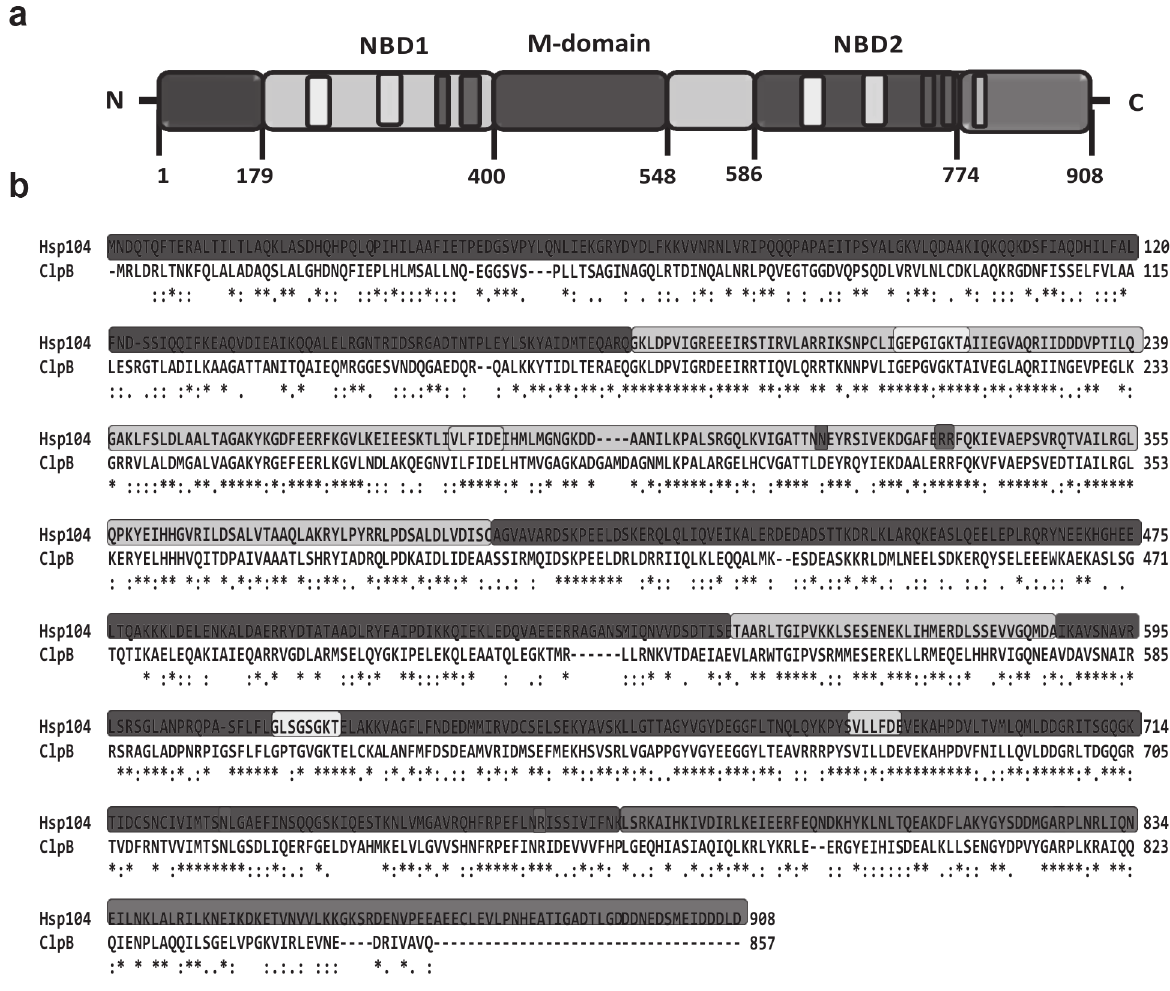
Figure 2 - ClpB/Hsp104. a) Schematic representation of the domains and motifs in Hsp100 proteins from the ClpB/Hsp104 subfamily. Domains from N- to C-terminal: N-terminal, NBD1, Walker A, Walker B, Sensor-1, arginine fingers, M-domain, NBD2, Sensor-2 and C-terminal. b) Amino acid alignment of Escherichia coli ClpB and Saccharomyces cereviseae Hsp104. Gray patterns are the same as in A) (modified from Lee et al. 2003 and Shirmer et al.